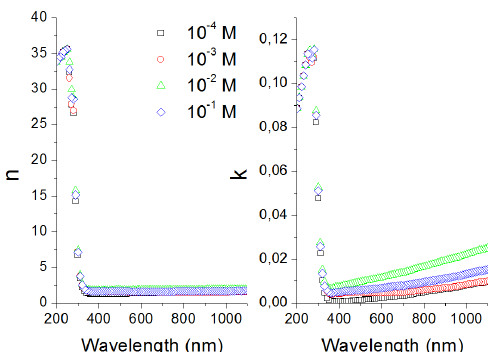
Fig. 5. Refractive index (n) and extinction coefficient (k) for the thin films with different deposition